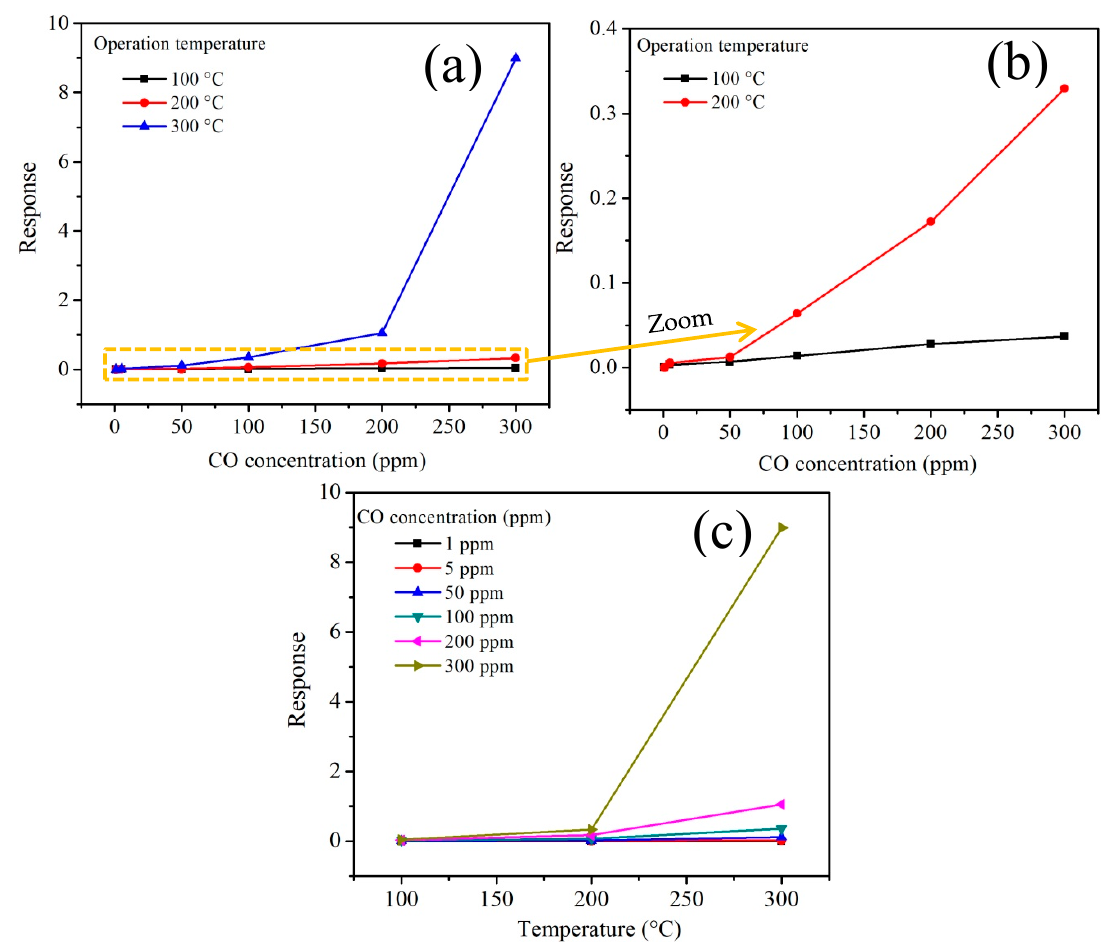
Figure 10. Response of the manganese antimonate nanoparticles in terms of ( a ) CO concentration, ( b ) concentration at 100 and 200 °C and ( c ) temperature.